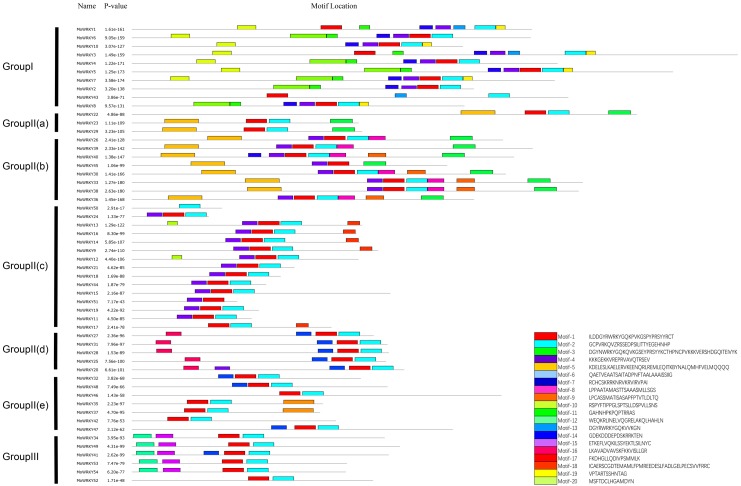
Distribution of conserved motifs in MoWRKYs.Different colors represent different motifs.